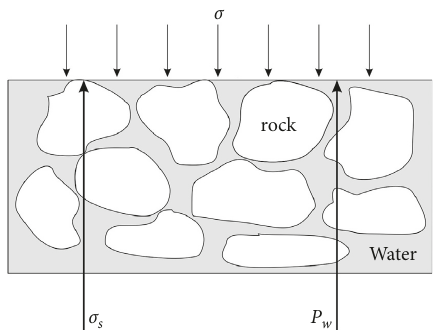
Figure 4: Stress diagram of a confined aquifer